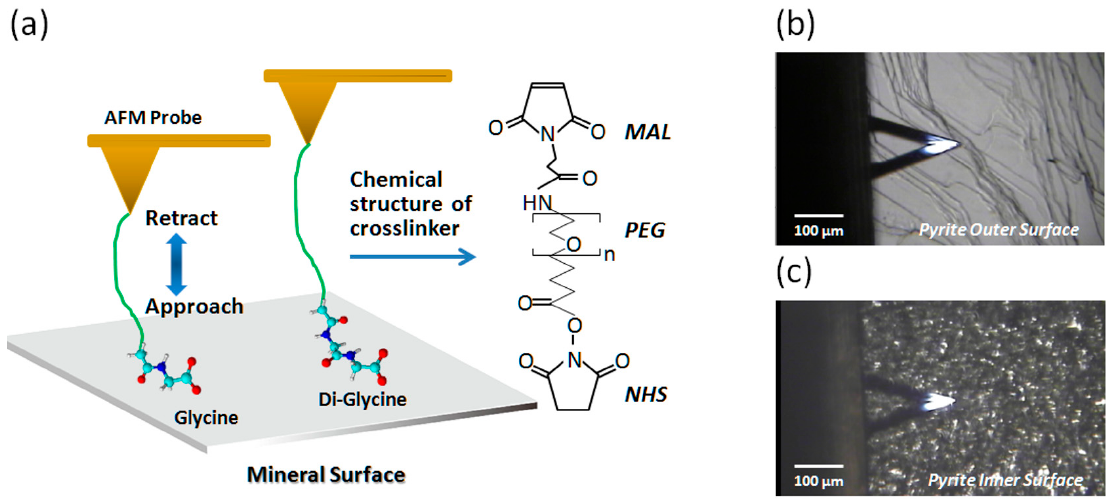
Figure 1. Schematic representation of this work. ( a ) The concept of stabilized binding of longer oligomers on a mineral surface eventually increasing the surface concentration of polymerized molecules. Amino acids and short oligopeptides were tethered to a hetero bi-functional polyethylene glycol (PEG) crosslinker through aminolysis of the NHS part and as a consequence, Gly and the Gly oligomers used in this study have one negative charge but no positive charge, while Lys and PLL contain additional positive charges. Optical microscopic images of the pyrite surface during force curve measurements on the atomic force microscopy (AFM); ( b ) outer surface of pyrite with steps and terraces clearly visible; and, ( c ) inner surface of pyrite showing different features than that of outer surface.